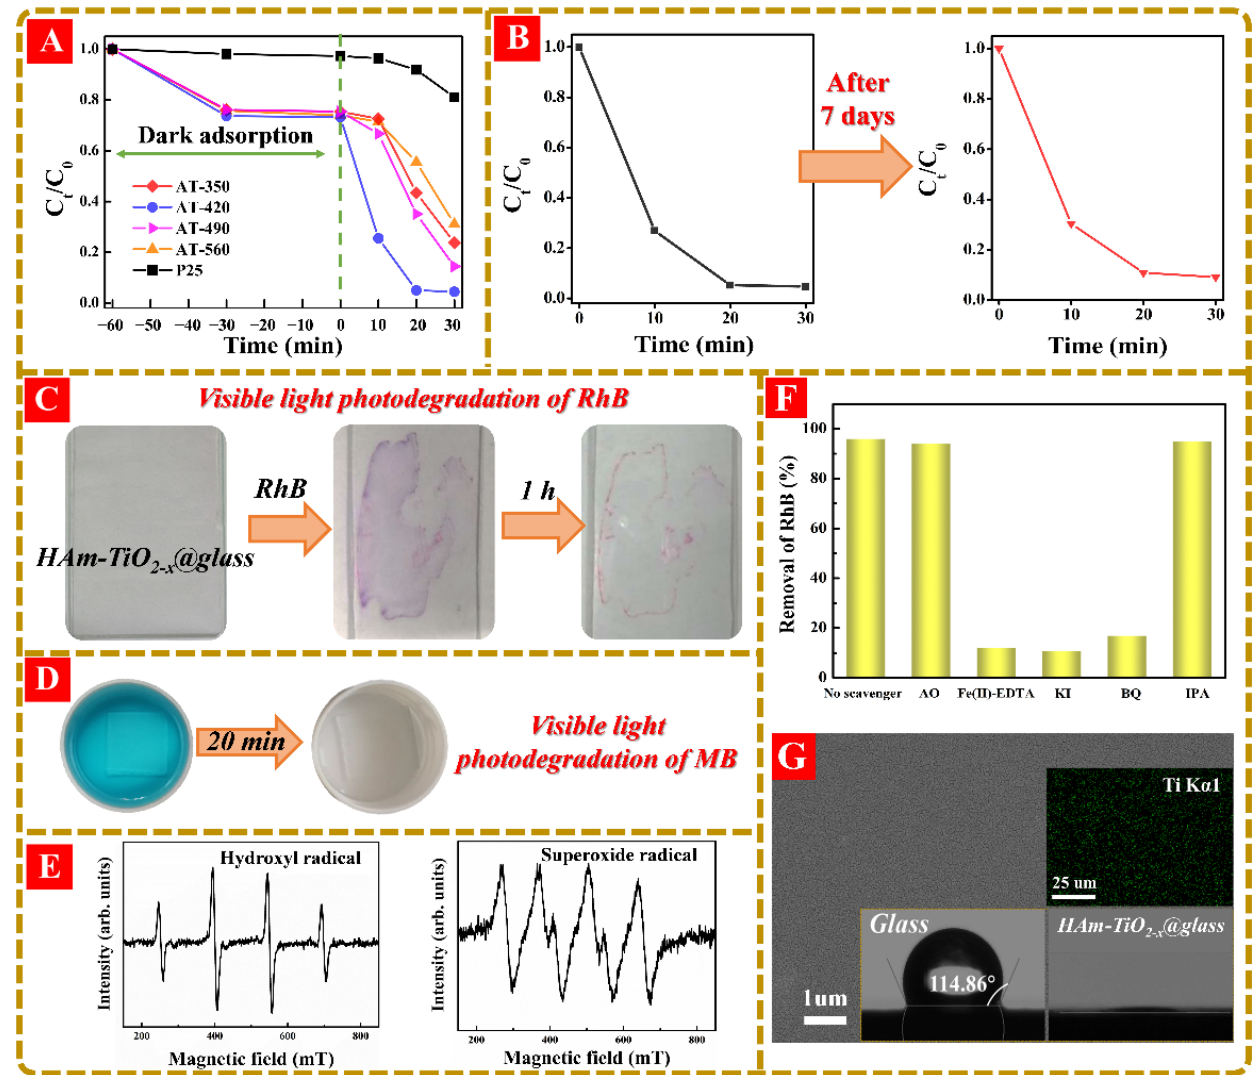
Figure 8. ( A ) The visible-light photodegradation of RhB for all samples and ( B ) the visible-light photodegradation stability test for AT-420. The visible-light photodegradations of ( C ) RhB and ( D ) MB using HAm-TiO 2 − x coated glass. ( E ) The EPR detection of · O 2 − and · OH over AT-420 under visible-light illumination. ( F ) The removal rates of AT-420 in the presence of different scavenging species. ( G ) Large-view SEM picture of HAm-TiO 2 − x coated glass, the EDS mapping of Ti element and the hydrophilicity test in HAm-TiO 2 − x coated glass were shown in the inset.